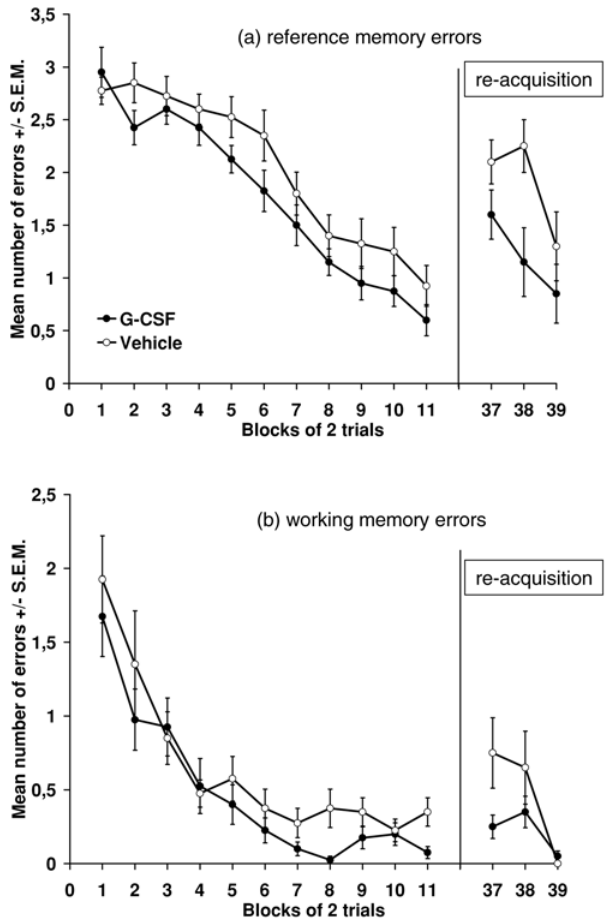
Figure 2. Spatial reference (a) and working (b) memory- formation in rats treated with vehicle or G-CSF during the spatial learning and re-acquisition. G-CSF significantly improved reference memory during the acquisition (Blocks 1–11; p=0.015; ANOVA with repeated measures) and re-acquisition (Blocks 37–39; p=0.004) period. Furthermore, G-CSF improves working memory in the re-acquisition (p=0.033) but not in the initial acquisition phase